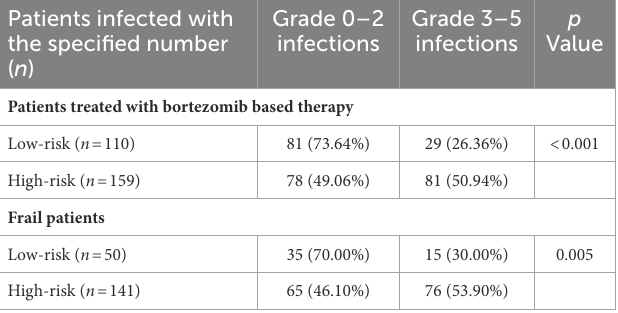
TABLE 4 Grouping and infection of patients treated with bortezomib-based therapy and frail patients in the FIRST score. Patients infected with the specified